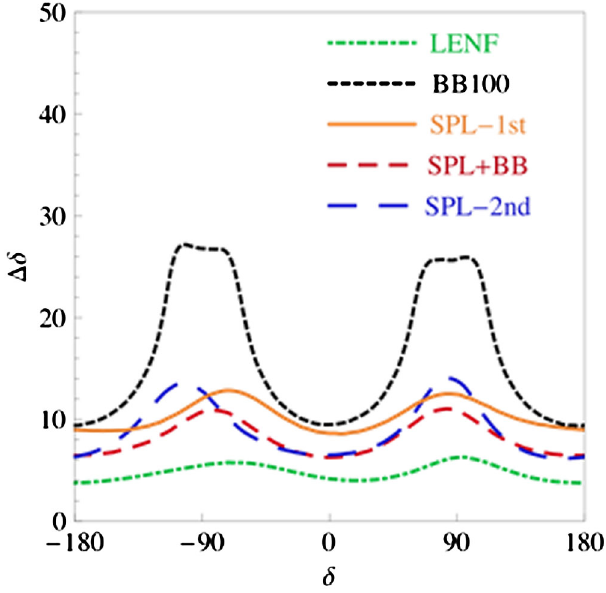
FIG. 25. The 1 (cid:9) measurement errors for the CP angle (cid:4) as a